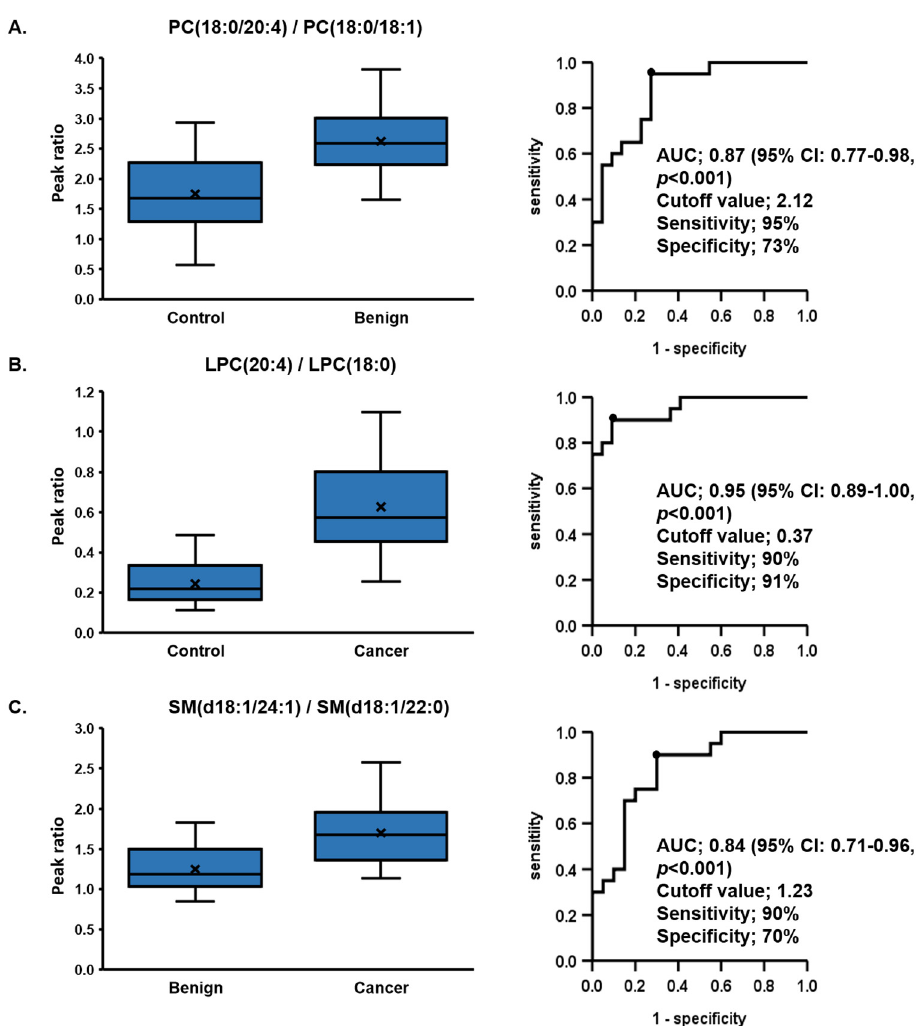
Figure 3. Receiver operating characteristic analysis of phospholipids ratios. ( a ) The area under the curve (AUC) of the capacity of the ratios of PC (18:0/20:4)/PC (18:0/18:1) to differentiate benign from control was 0.87, ( b ) the AUC of the capacity of the ratios of LPC (20:4)/LPC (18:0) to differentiate cancer from control was 0.95, and ( c ) the AUC of the capacity of the ratios of SM (d18:1/24:1)/SM (d18:1/22:0) to differentiate benign from control was 0.84. The intergroup difference was compared using the Mann–Whitney U Test. Table 3. The area under curves (AUCs) for phospholipids, lysophospholipids, sphingomyelin, their 95% confidence intervals (CI), p values, sensitivities, specificities, and cutoff values for ( a ) control vs. benign, ( b ) control vs. cancer, and ( c ) benign vs. cancer.